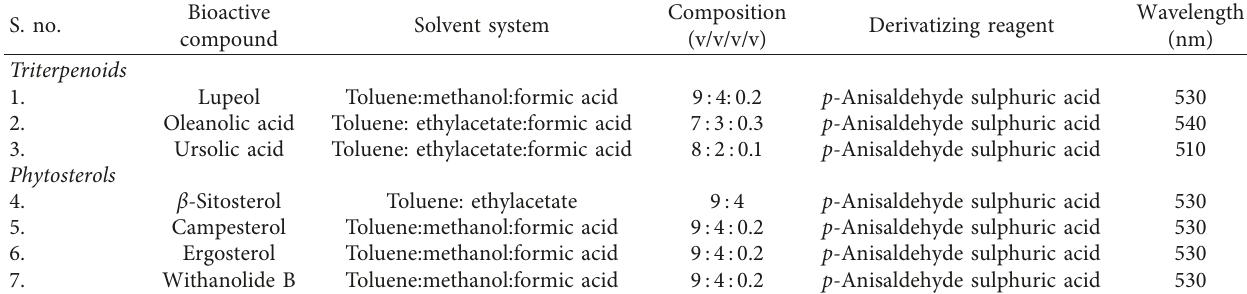
Table 1: Data showing bioactive markers, composition of solvent system, derivatizing reagent used and wavelength of all the marker compounds used in the present study for HPTLC analysis. S.